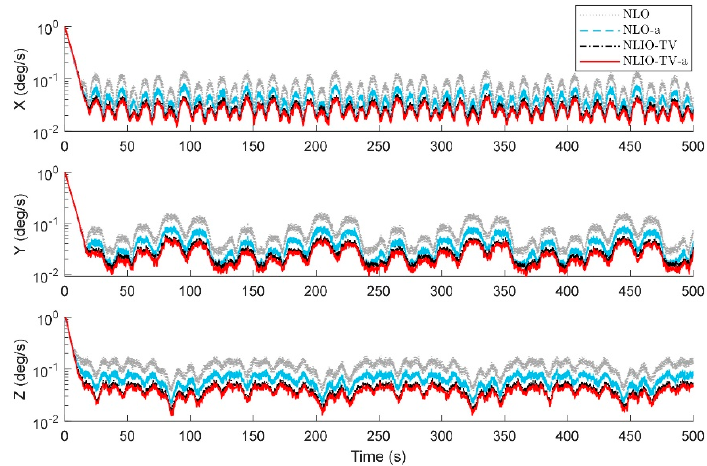
Figure 12. Averaged absolute attitude estimation error over 100 simulations.